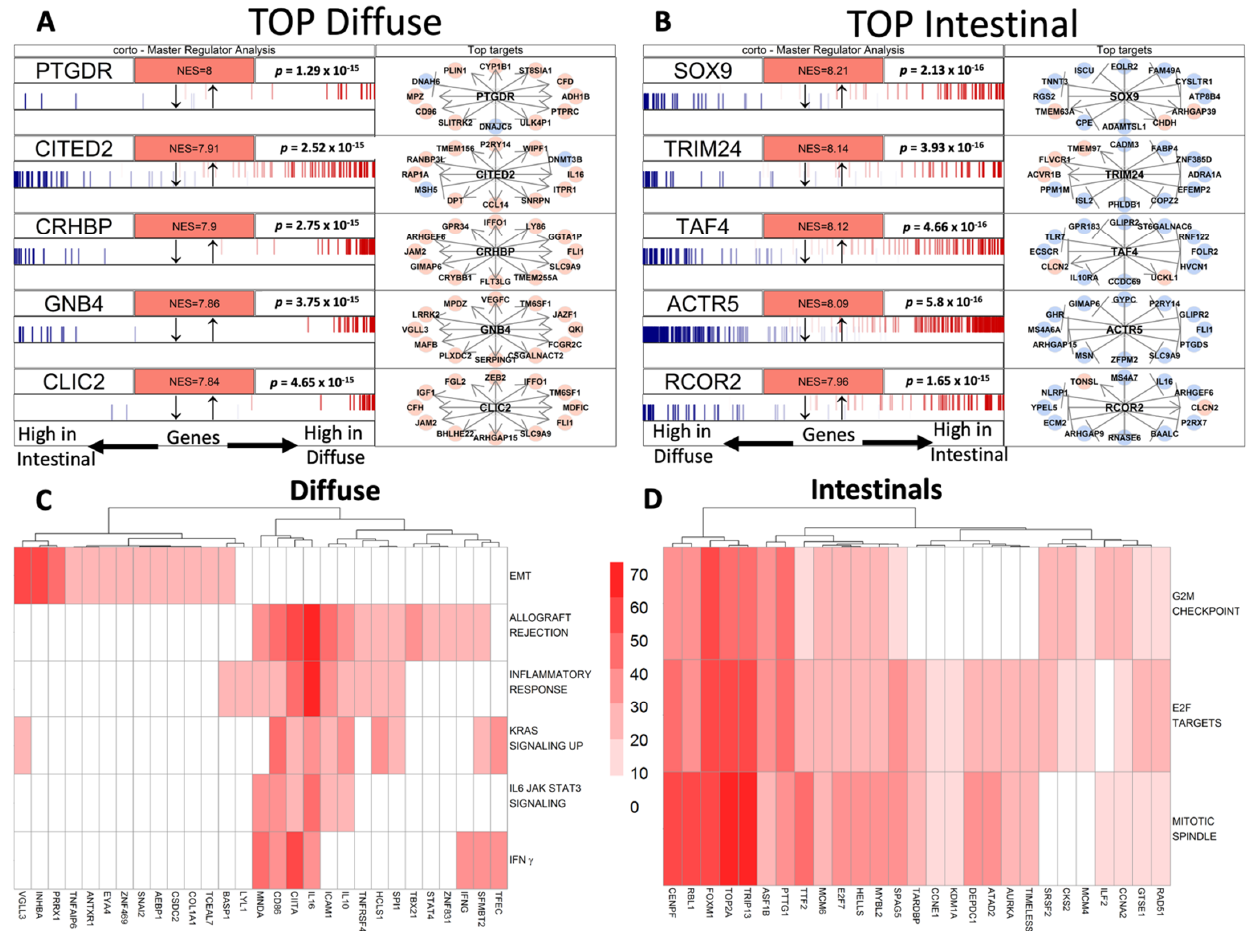
Figure 2. ( A , B ) Intestinal and Diffuse top master regulators. Each network is indicated by its MR. The genes in each network are shown in a barcode-like diagram showing all transcriptome genes from most downregulated (left) to most upregulated (right). Positively (red) and negatively (blue) correlated targets are overlaid on the differential expression signature as bars of different colors. Normalized enrichment score (NESes) and p-values are also indicated. To the right, the twelve highest-likelihood network putative targets of each MR are shown in red if upregulated or in blue if downregulated and with a pointed arrow if predicted to be activated by the centroid protein or with a blunt arrow if predicted to be repressed. ( C , D ) Heatmaps of the biological characterization of the top MRs in Diffuse and Intestinal subgroups. The intensity of the red color is proportional to the overlap between the genes in the regulon of the MR and the ones in the hallmark gene set.